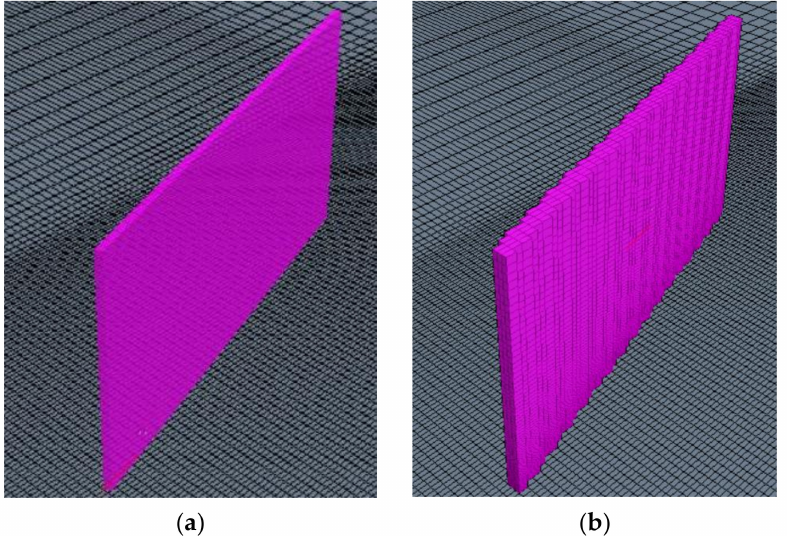
Figure 4. Sketch of the selected cells when using the cell-set model. ( a ) Geometry of the VG and ( b ) cell-set representation. With the cell-set model, meshes of around 7.2 million cells have been